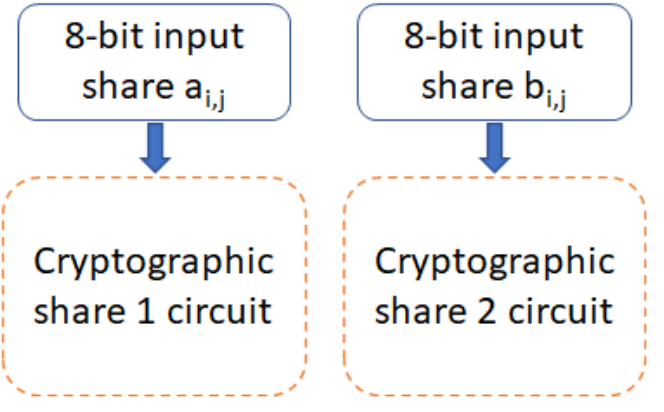
Figure 6. 8-bit input a i , j for Share 1 and 8-bit input b i , j for Share 2 , where i is the input bit, and j is the share